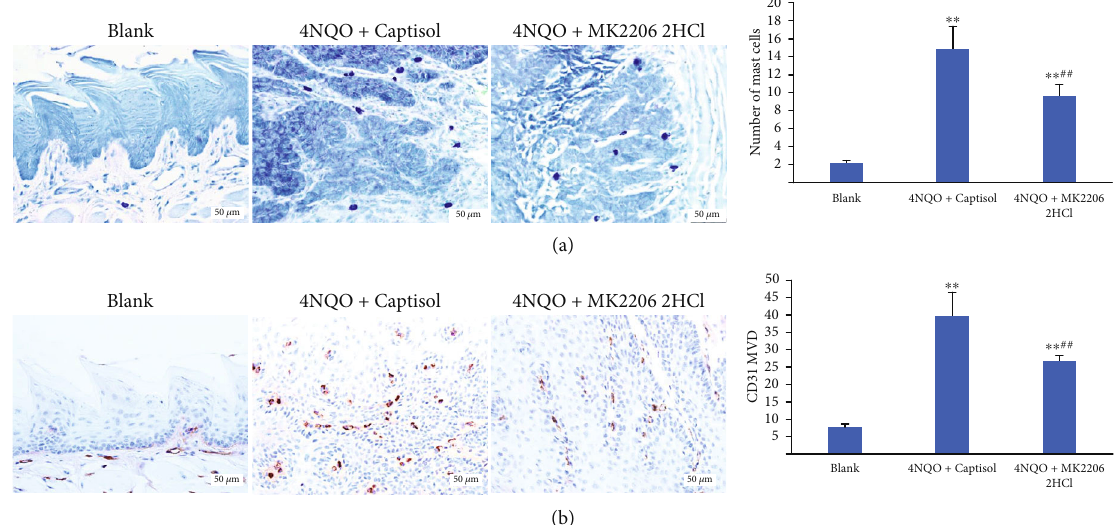
Figure 5: MK2206 2HCl suppressed MC in fi ltration and microvascular density in 4NQO-induced mouse tongue tumors. (a) MK2206 2HCl inhibited MC in fi ltration by toluidine blue staining. (b) MK2206 2HCl inhibited the microvascular density by IHC. All data are presented as the mean ± SD : ∗∗ P < 0 : 01 as compared with the blank group, ## P < 0 : 01 as compared with the 4NQO+captisol group. Magni fi cation ×